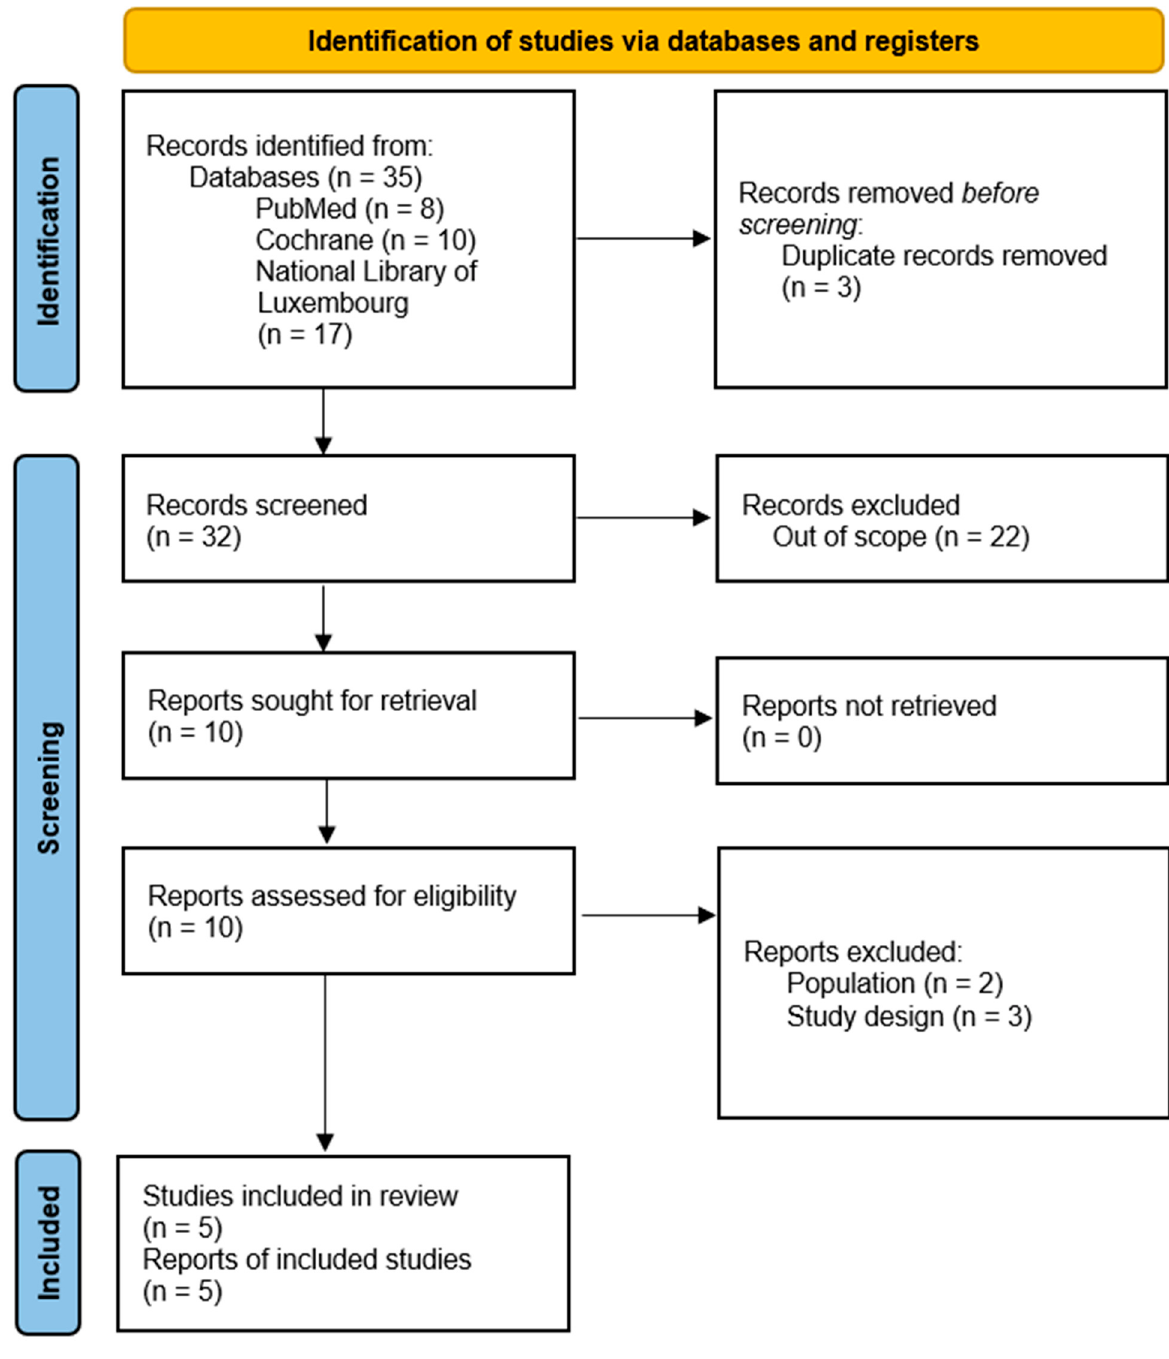
Figure 1. PRISMA 2020 flow diagram for new systematic reviews, including searches of databases and registers.